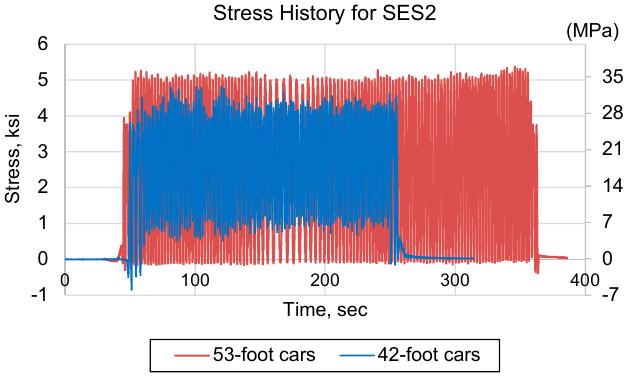
Figure 15. Stress calculated from measured strains, comparison for stringer S2 southeast.